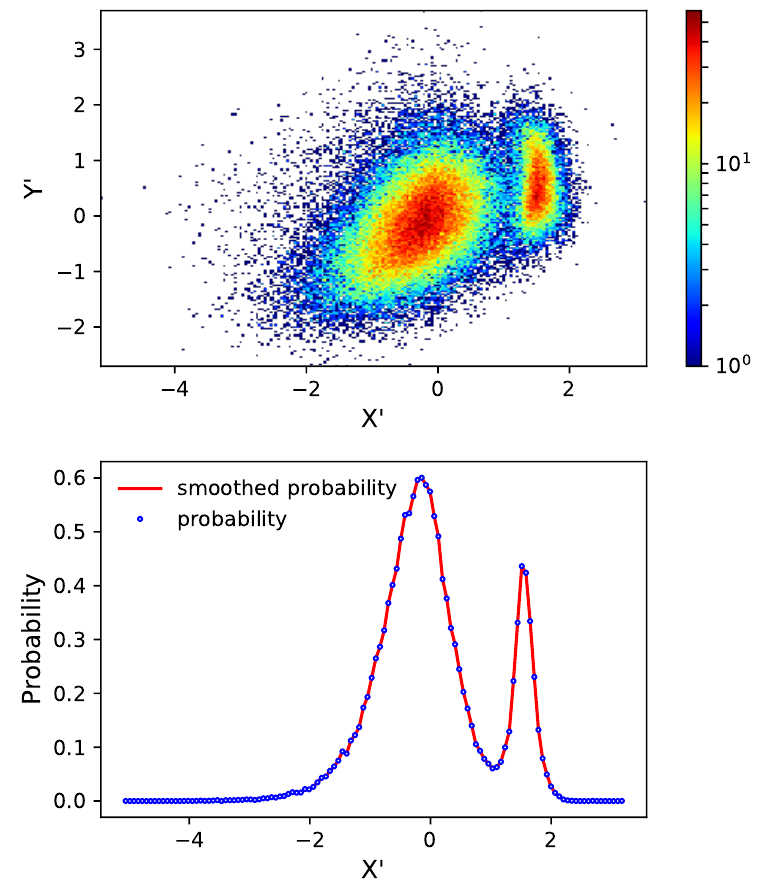
Figure 3. The distribution of the X (cid:48) , Y (cid:48) in the 350.0–700.0 GeV reconstructed energy